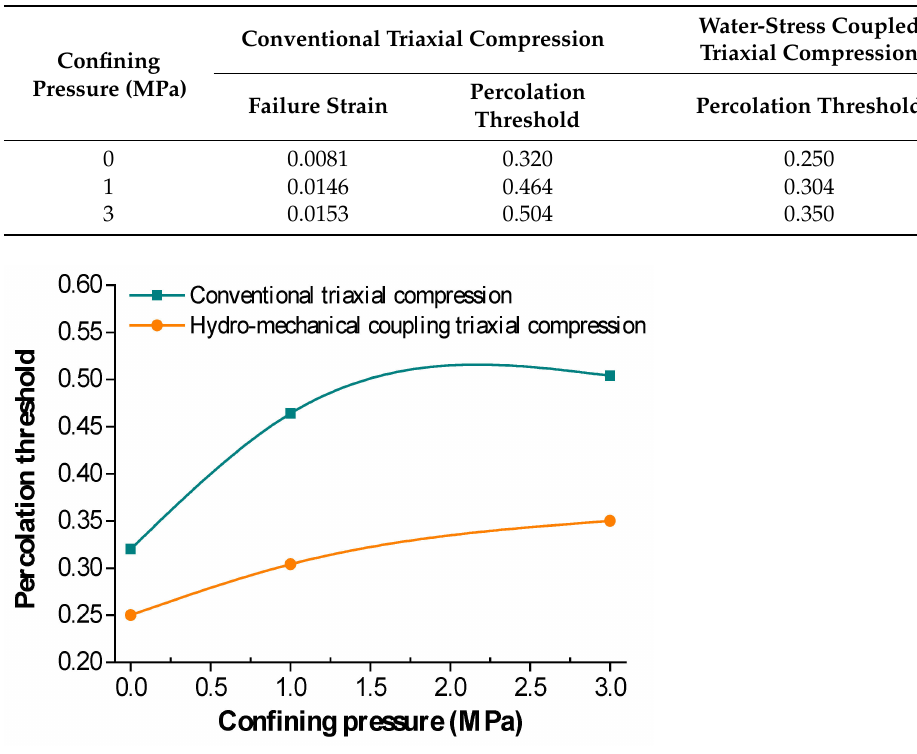
Table 4. Percolation threshold and failure strain under two kinds of triaxial compression.